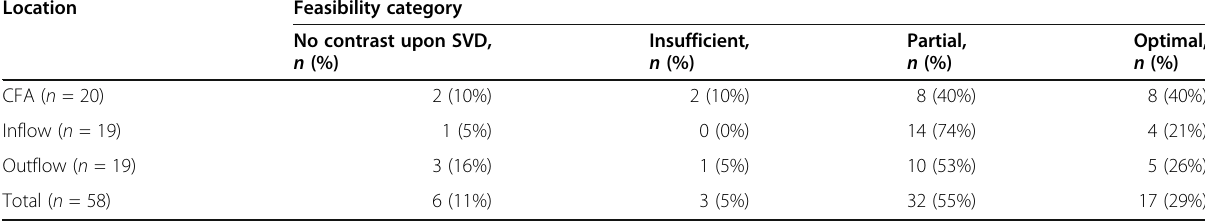
Table 3 Feasibility assessment per